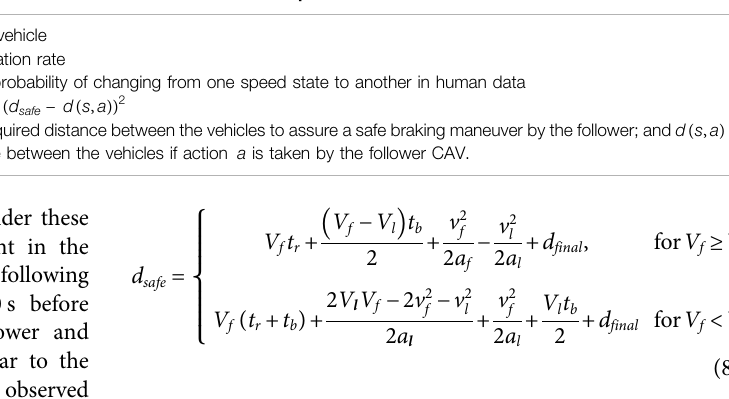
TABLE 6 | Proposed MDP structure to design a CAV braking pro fi le under car-following driving condition. States